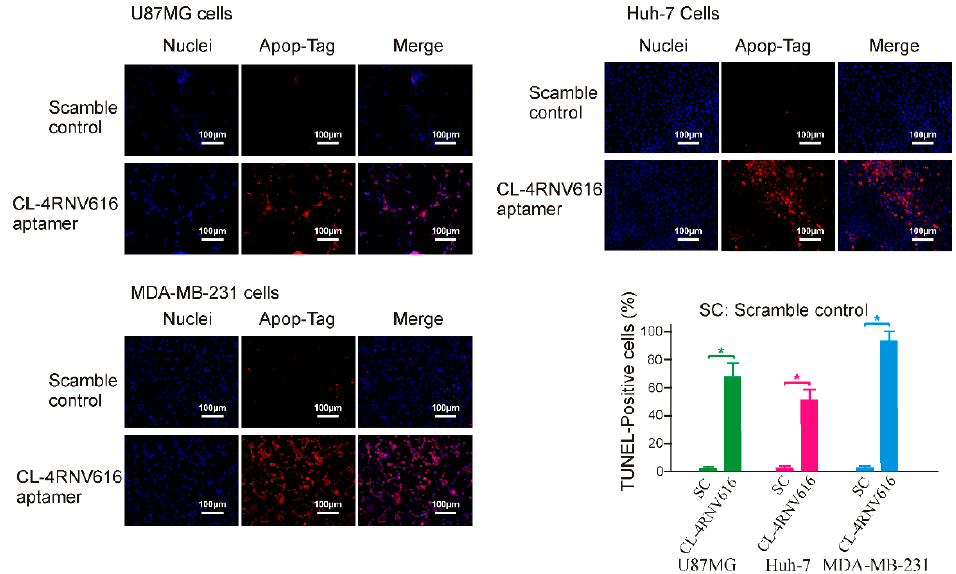
Figure 7. Evaluation of apoptotic induction effect of CL-4RNV616 aptamer on EGFR positive cancer cells. Representative micrograph of TUNEL assays on indicated cells after 72 h of treatment (at 500 nM). Blue, Hoechst 33342 (nuclei) and red, Rhodamine for apopTag-positive nuclei. The relative quantification was determined via the Image J program. * p < 0.05.